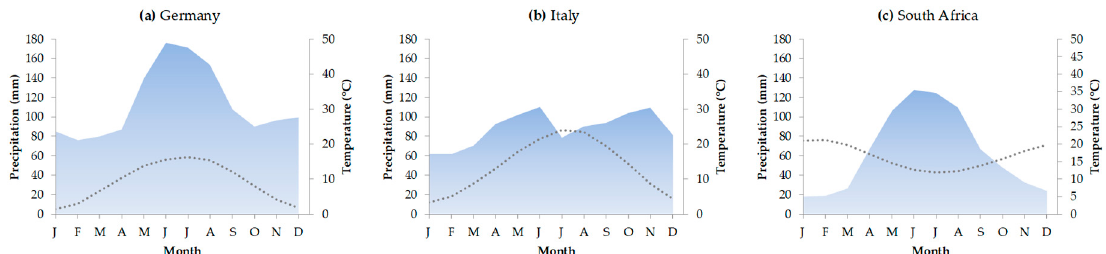
Figure 2. Climate graphs for study sites: ( a ) Germany, ( b ) Italy, and ( c ) South Africa; calculated with available climate data (monthly resolution) for the period 1950–2010. The black dotted lines indicate the temperature and the blue area plots indicate the precipitation for each country. J: January; F: February; M: March; A: April; M: May; J: June; J: July; A: August; S: September; O: October; N: November; D: December.